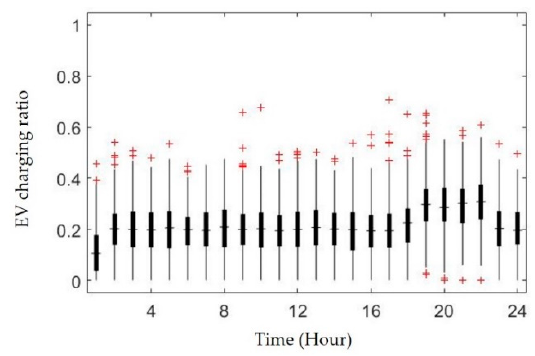
Figure 3. Statistical information on annual EV charging pattern of Case C.